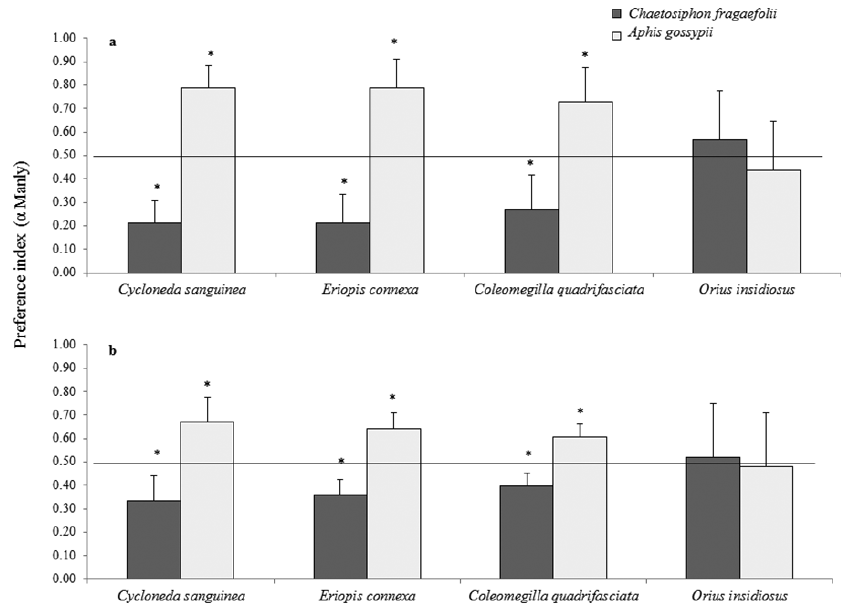
Figure 2 - Manly’s index values of preference assay for different predator species on a ) nymphs and b ) adults of C. fragaefolii and A. gossypii . Line indicates the reference value of 0.50 that indicates indifference, values > 0.5 preference and values < 0.5 rejection. Asterisk indicates significant differences from 0.5 using the two-tailed t test for a single